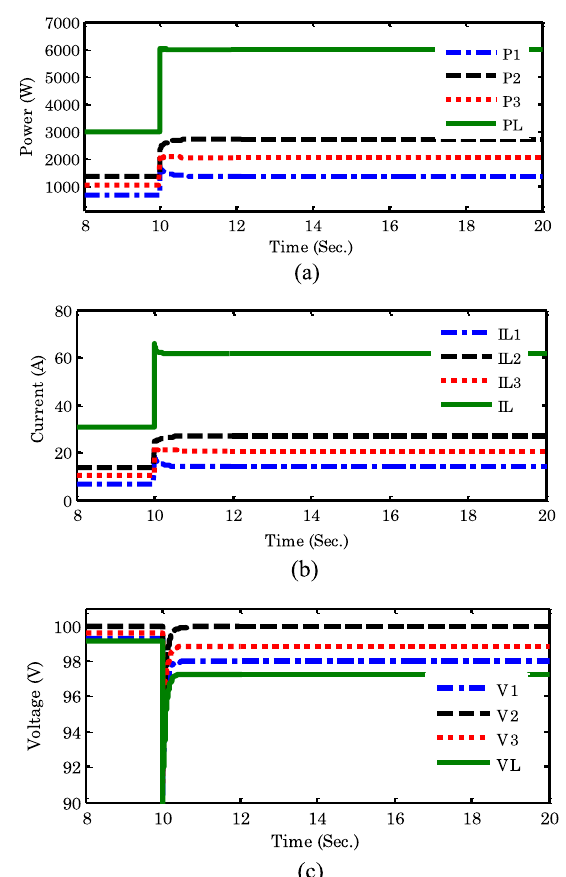
Fig. 5 Performance of the proposed primary control method, ( a ) Output power, ( b ) Output current, ( c ) Output voltages of the converters and load